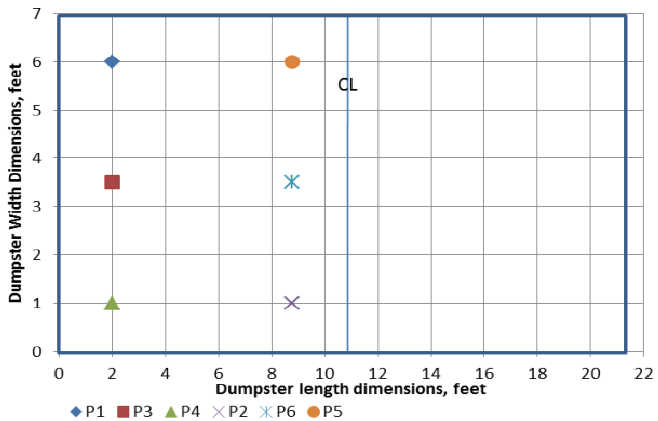
Figure 9. Plan view of the test chamber showing the location of CO an elevation of 25 cm. All points are in one half of the chamber taking advantage of symmetry about the centerline